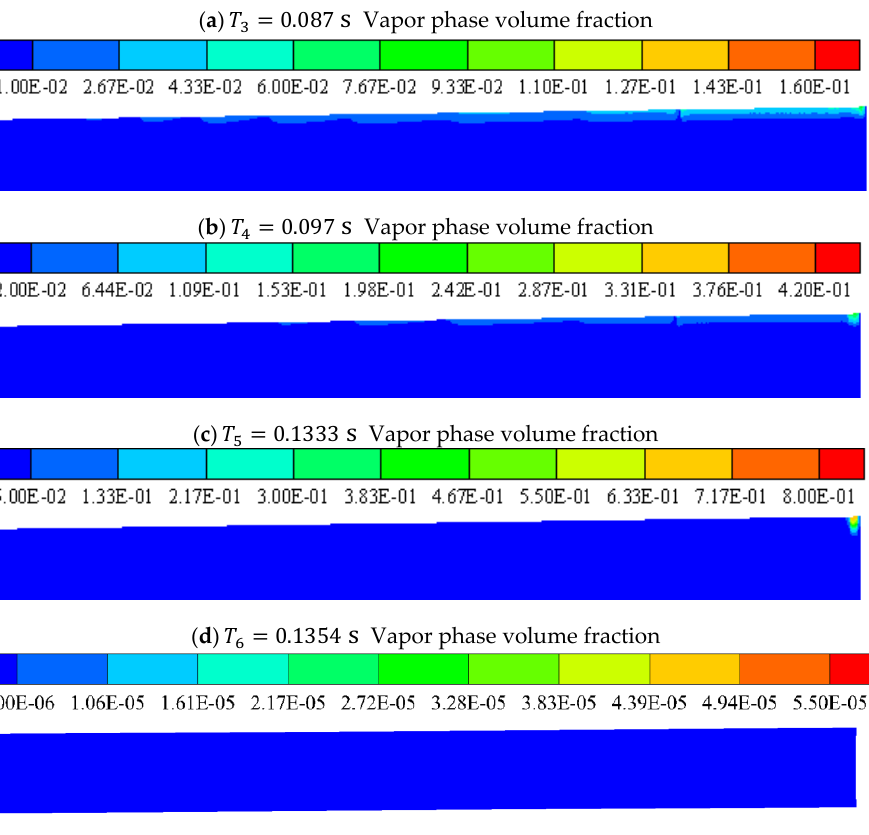
Figure 34. Pressure field evolution on the axis plane of the pipeline in the cavity collapse stage.